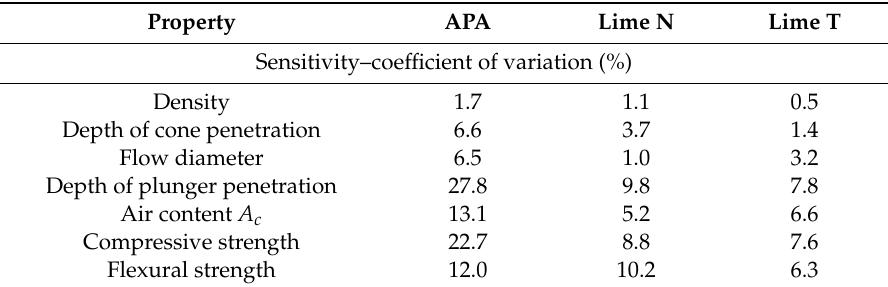
Table 8. The sensitivity of properties of masonry mortar to changing cement